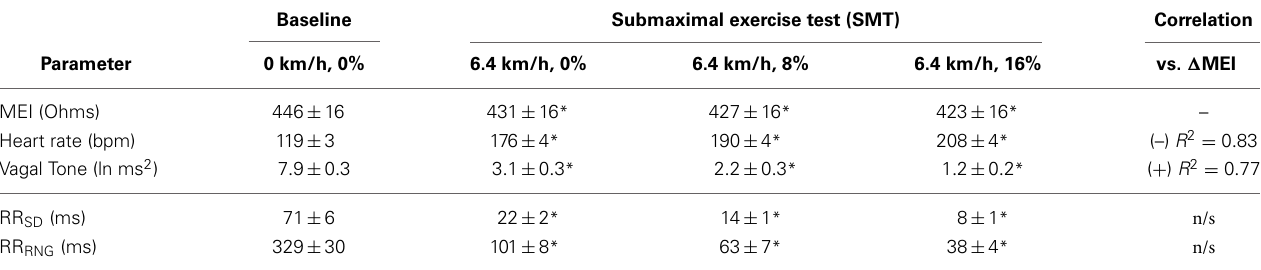
Table 1 | Myocardial electrical impedance (MEI), heart-rate (HR) and ECG-derived indices of heart rate variability in awake-unsedated dogs with healed left-anterior descending (LAD) myocardial infarcts, both before (baseline) as well as during a submaximal exercise